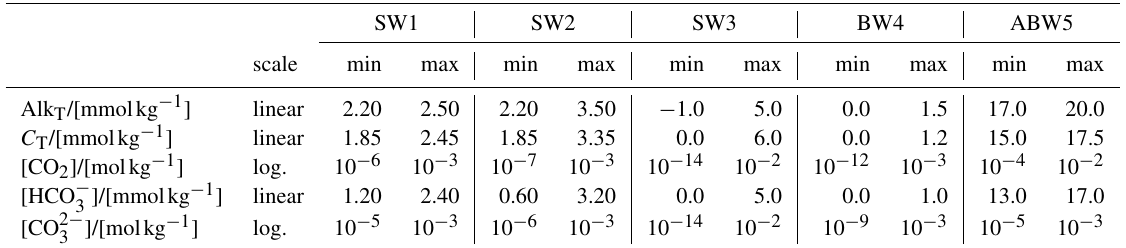
Table 1. Ranges of variation for the input variables for the five test cases. Experiments always considered Alk T and either one of C T , [CO 2 ], [HCO − ] or [CO 2 − 3 3